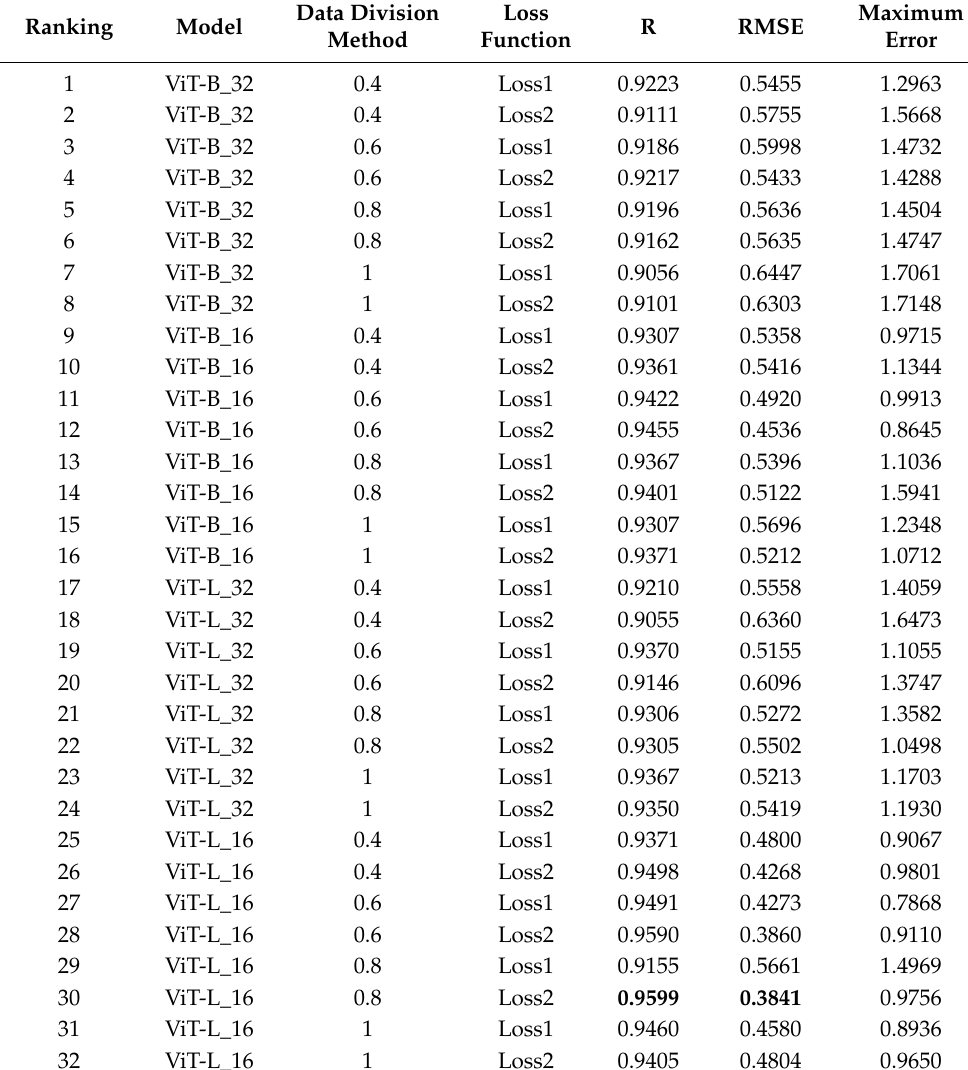
Table 2. Comparison results of visual transformer